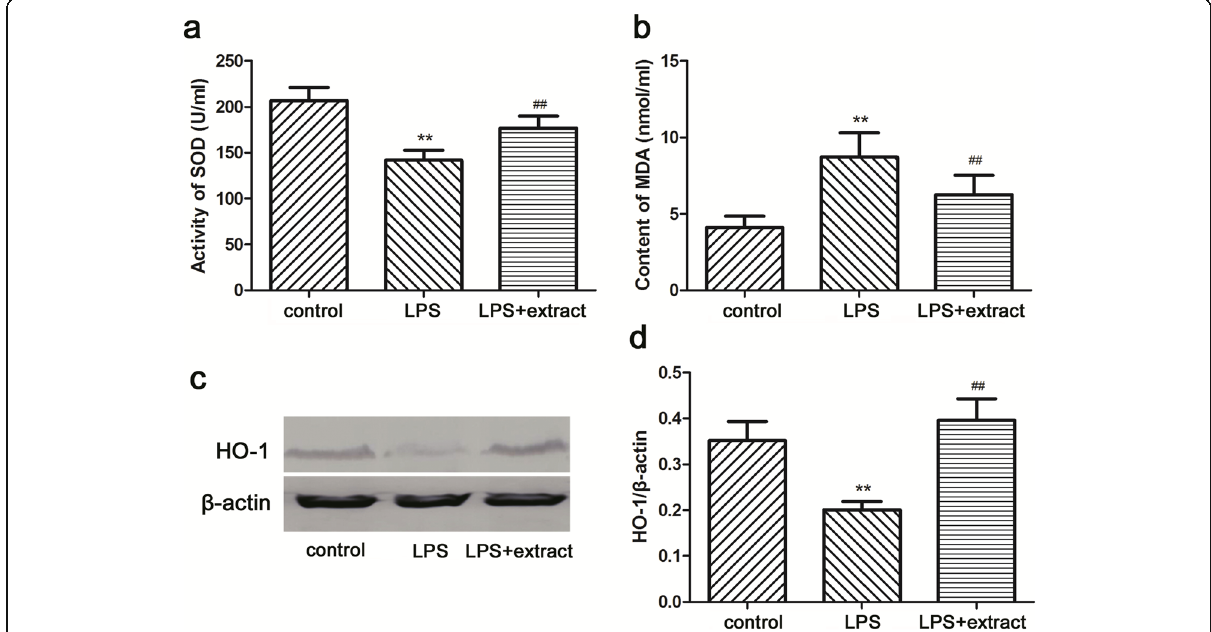
Fig. 2 Effect of the venom extract on antioxidants. Serum SOD activity ( a ) and MDA content ( b ) were measured. The results were expressed as means ± SD ( n = 10). HO-1 expression in hearts was analyzed by western blot ( c ). Relative amount of HO-1 was assessed by HO-1 to β -actin ratio ( d ) ( n = 6). ** p < 0.01 vs. Control group; ## p < 0.01 vs. LPS